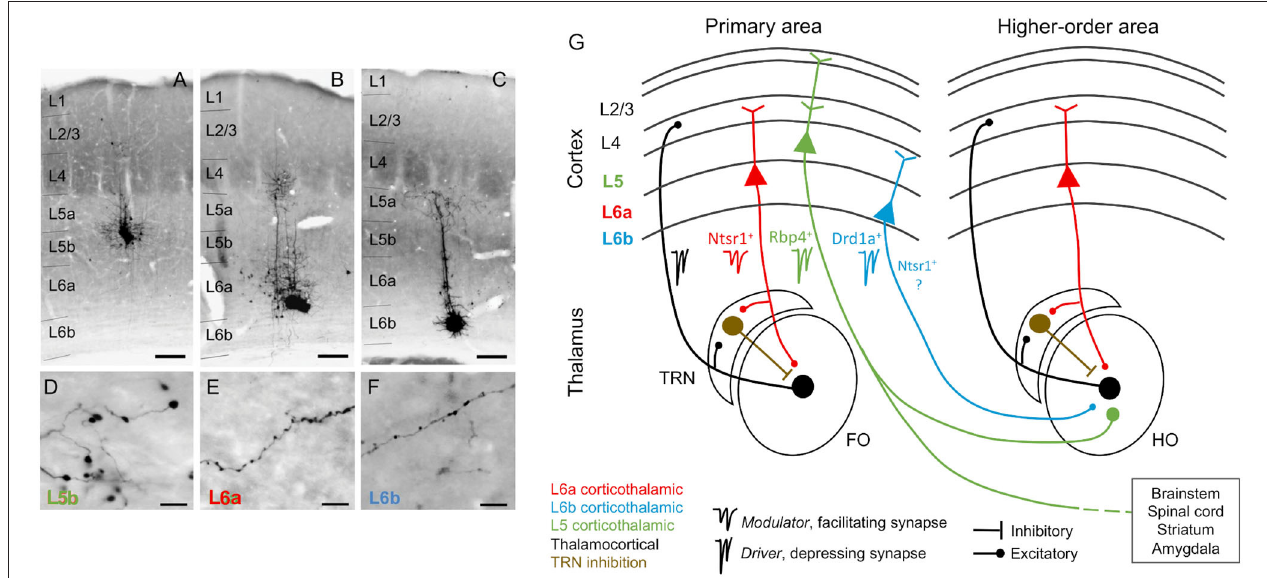
FIGURE 1 | Corticothalamic neurons and circuits. (A–C) Photomicrographs showing BDA microdeposits in L5b, L6a, and L6b neurons of primary somatosensory barrel field (D–F) , and their respective axonal arborizations in (higher order) posterior thalamic nucleus. Cortical pyramidal neurons differ in the morphology of their axonal varicosities. Scale bars: A–C = 150 µ m, D–F = 10 µ m. (G) Schematic and simplified view of corticothalamic and thalamocortical circuits, based on information from several sensory systems (auditory, visual, and somatosensory). Red, L6a CT projections, modulator (Ntsr1 + ): feedback projections that send collaterals to the TRN, a GABAergic nucleus that provides inhibition to the thalamus (brown). Black, thalamocortical, feedforward projections that form reciprocal loops with L6a feedback projections. Green, L5 CT projections, driver (Rbp4 + ): project non-reciprocally to a hierarchically higher order thalamic nucleus and form part of transthalamic corticocortical pathways; they are collaterals from long-range axons that project to other subcortical centers (e.g., brainstem, spinal cord, striatum, and amygdala). Blue, L6b CT projections, driver (Drd1a + ): project non-reciprocally to a hierarchically higher order thalamic nucleus; it is unknown if Drd1a + and Ntsr1 + neurons in L6b are overlapping or distinct neuronal populations. As insets, examples of specific markers from Cre mouse lines that can be used to selectively target neurons of each CT circuit [Ntsr1-Cre, Drd1a-Cre, and Rbp4-Cre mice, for L6a (red), L6b (blue), and L5 (green) CT neurons]. FO, first order thalamic nuclei; HO, higher order thalamic nuclei; TRN, thalamic reticular nucleus; L2/3, cortical layers 2 and 3; L4, cortical layer 4; L5, cortical layer 5; L6a, cortical layer 6a; L6b, cortical layer 6b; Photomicrographs (A–F) after Hoerder-Suabedissen et al.